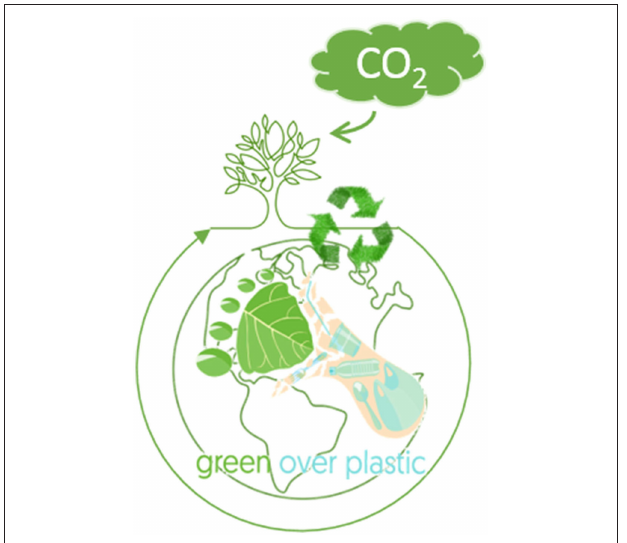
FIGURE 1 | Green manufacturing of Bio-Plastics and recycling of FD-Plastics within the circular